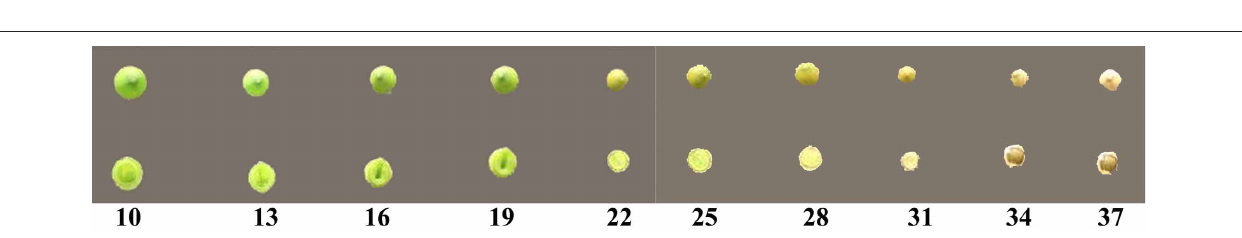
blot analysis to confirm the T-DNA integration. However, not all of them are siuitable for determining the copy number of trans- genes. Bam HI, Dra I, Eco R5, Hin dIII, Kpn I, Pst I, and Xba I gave 2 bands with the DNA from one transgenic line ( Figure 5A ) and